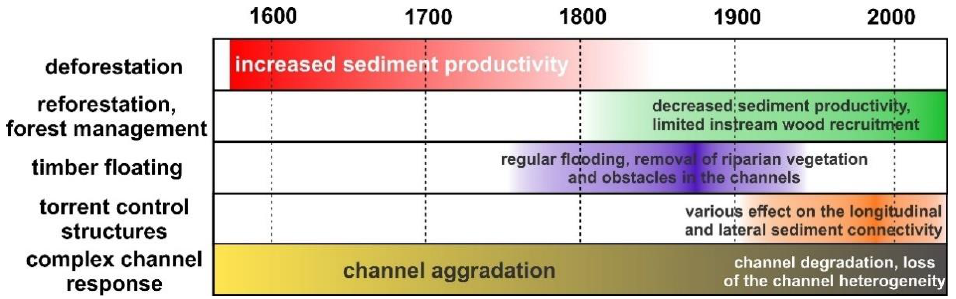
Figure 7. General response of mountain headwater channels in the studied region to the main human interventions.